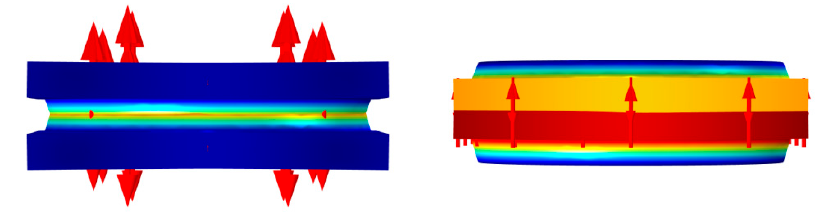
Figure 16. Vibration displacement diagram of “cavity cave” end